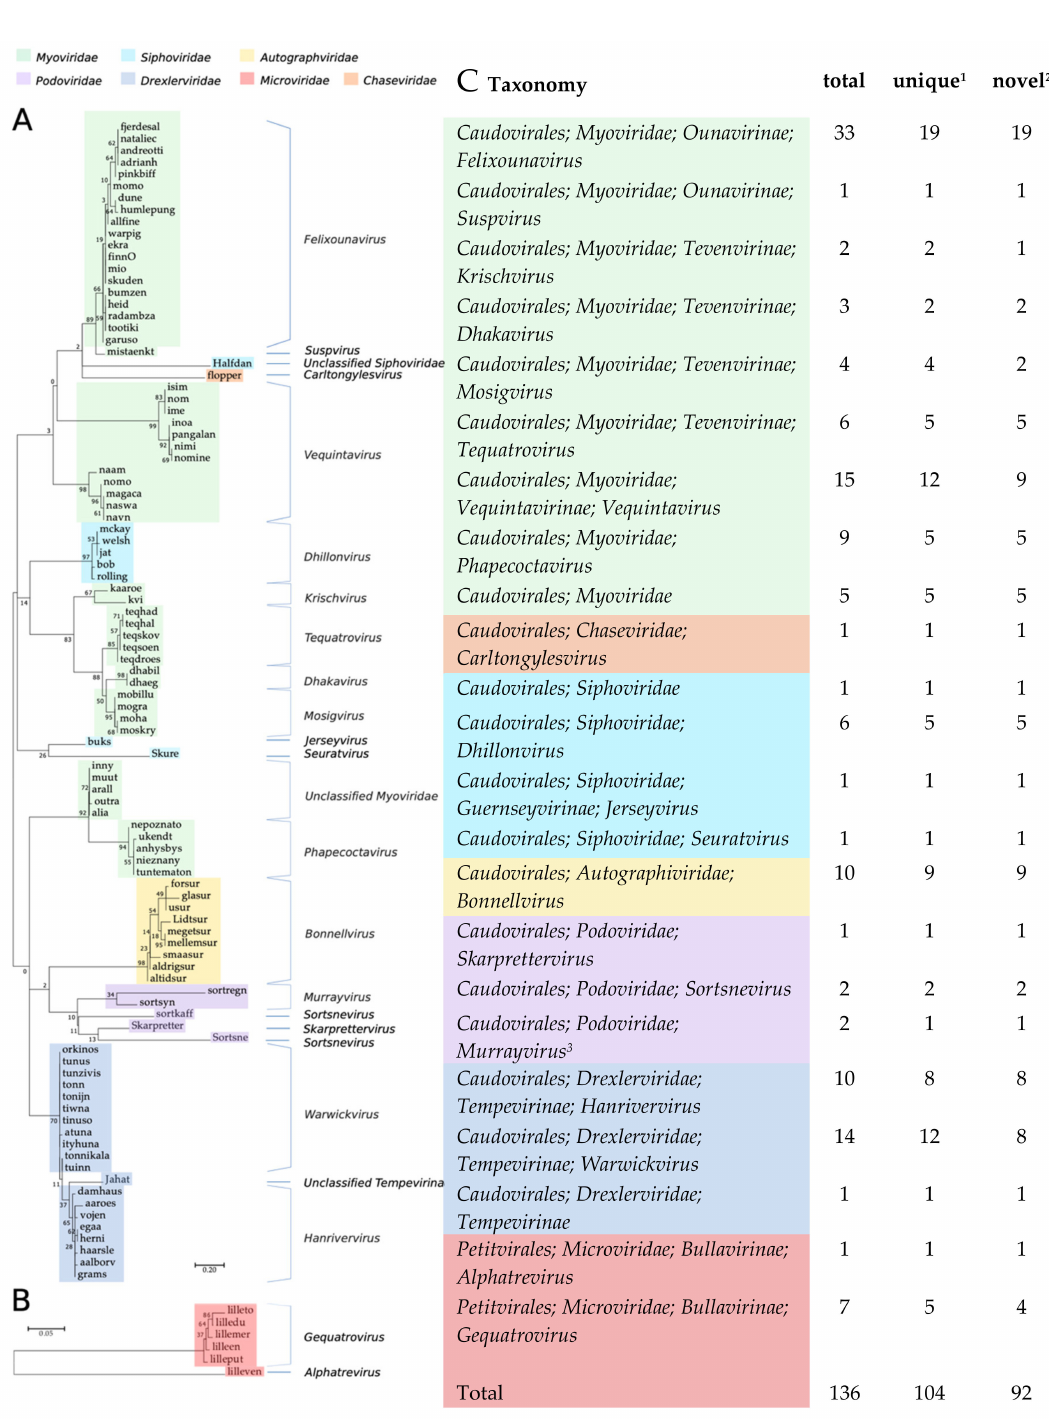
Figure 1. Phylogenetic trees, bootstrap: 100, scalebar: substitutions per site. ( A ) Caudovirales based on large terminase subunit terL (Maximum log Likelihood: − 1801.27). ( B ) Microviridae based on the DNA replication protein gene gpA (Maximum log Likelihood: − 3922.55). ( C ) Taxonomic distribution of phages identified in 94 Danish wastewater samples, based on similarity to closest related and the ICTV Master Species list. 1 ≤ 95% similarity to other phages in the dataset. 2 ≤ 95% similarity to other phages in the dataset and the NCBI GenBank. 3 The Murrayvirus genus has by mistake been classified as Siphoviridae , but a proposed move to Podoviridae will be included in the 2021 ICTV